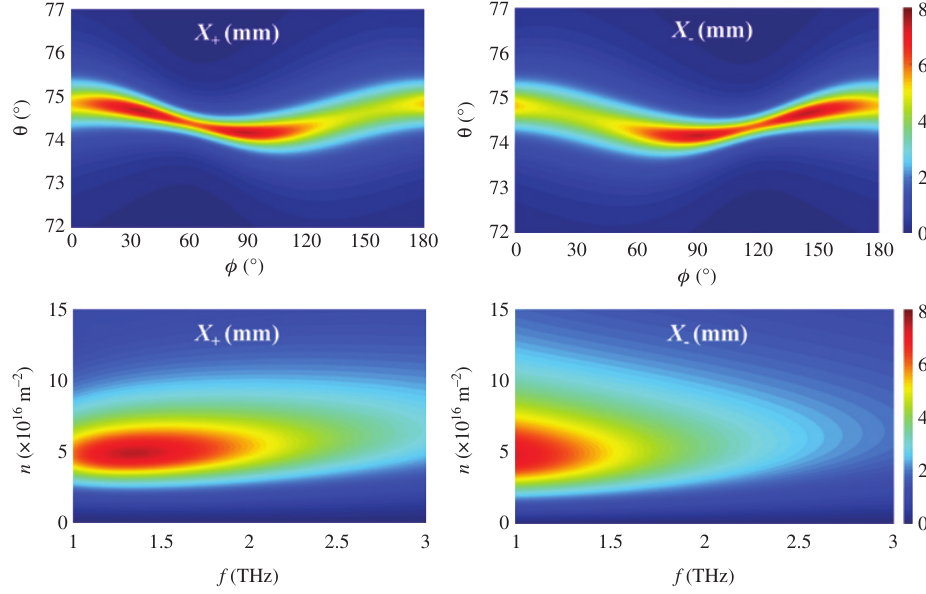
with rotating angle and incident angle, frequency and carrier density. Figure 4: Change of displacement X ± (A, B) The displacements X changing with the rotation angle φ and incident angle θ . (C, D) The dependences of X ± carrier density n for θ = 74.1 ° and φ = 30 °